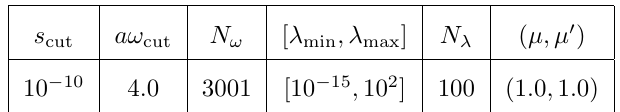
Table 1 . Parameters for the present sparse-modeling analysis.